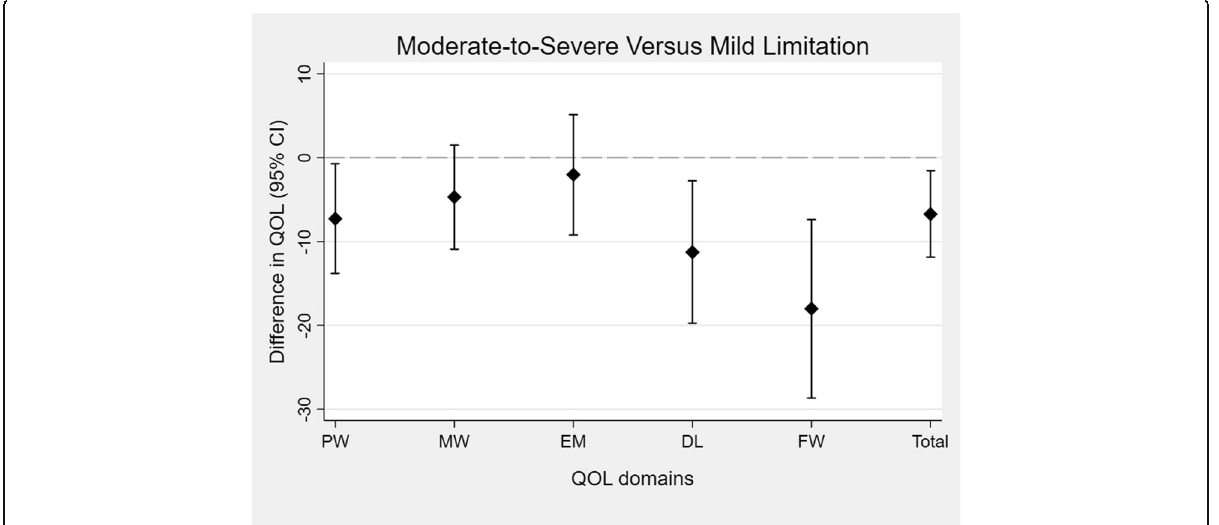
Fig. 1 Differences in mean quality of life scores between caregivers of PWD whose care recipients had moderate-to-severe (FAST 6a or above) and mild functional limitation (FAST 5 or below). PW: Physical Well-being; MW: Mental Well-being; EM: Experience & Meaning; DL: Impact on Daily Living; FW: Financial Well-being; Total: QOL total score